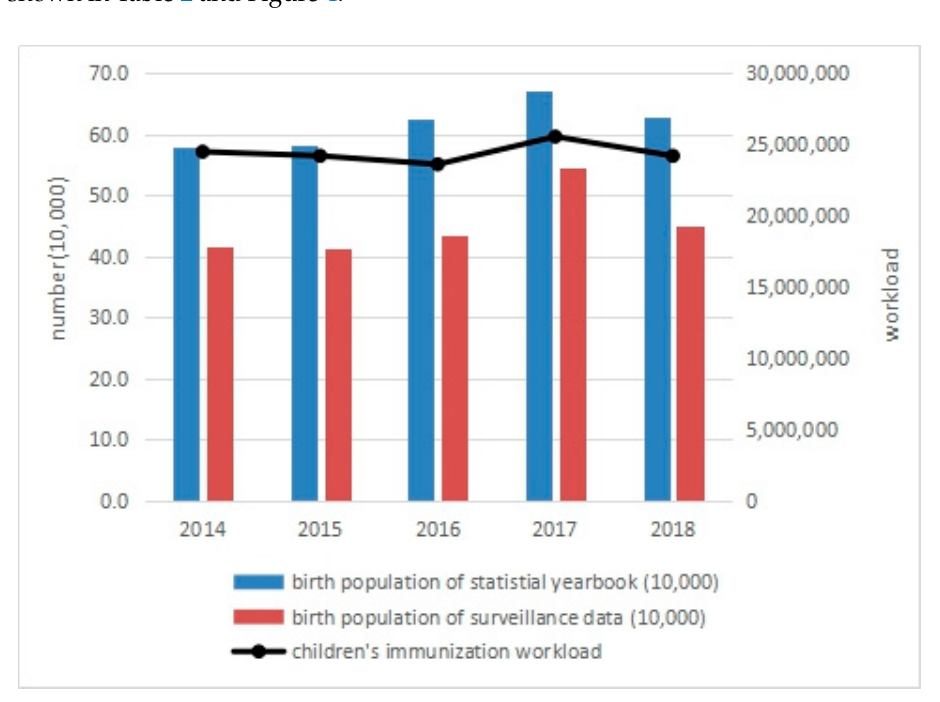
Figure 3. Child health management workload in Zhejiang Province, 2014–2018.